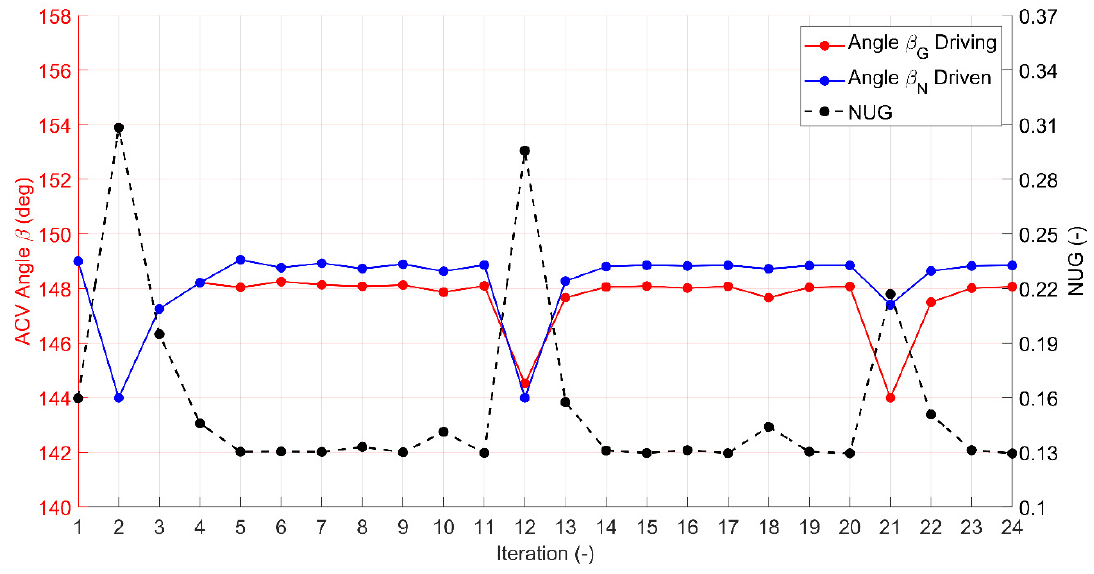
Figure 23. Second optimization process trend.